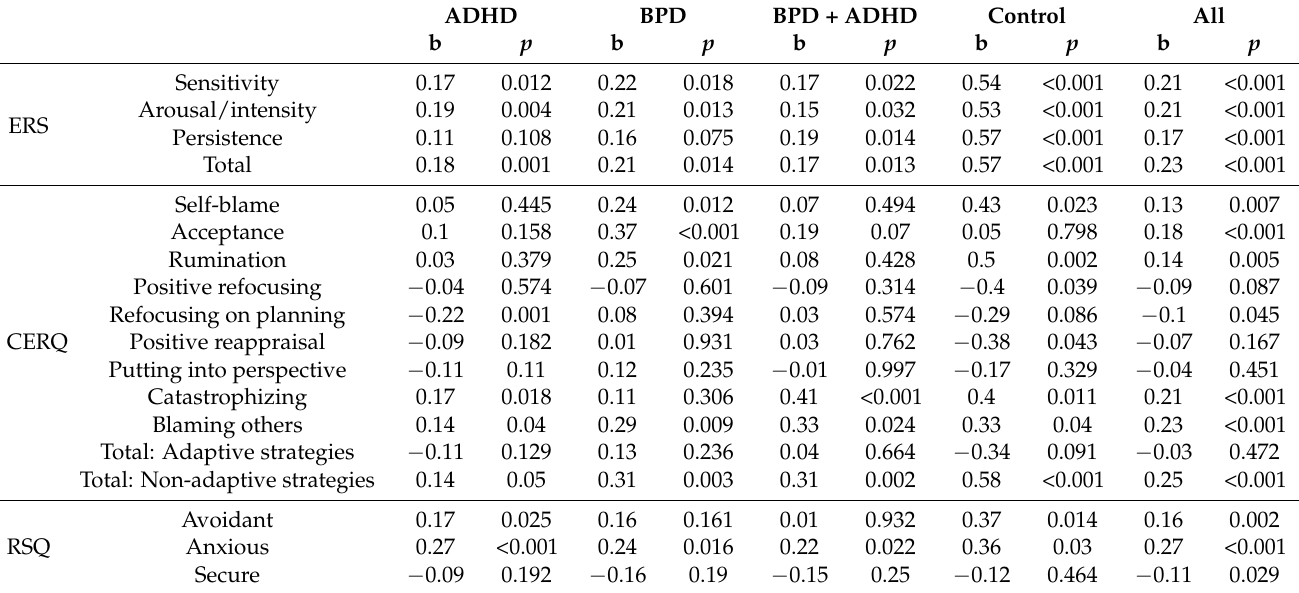
Table 2. Association between CTQ total score and ERS, CERQ, and RSQ questionnaires for ADHD, BPD, BPD + ADHD, and Control groups and the whole population (All).